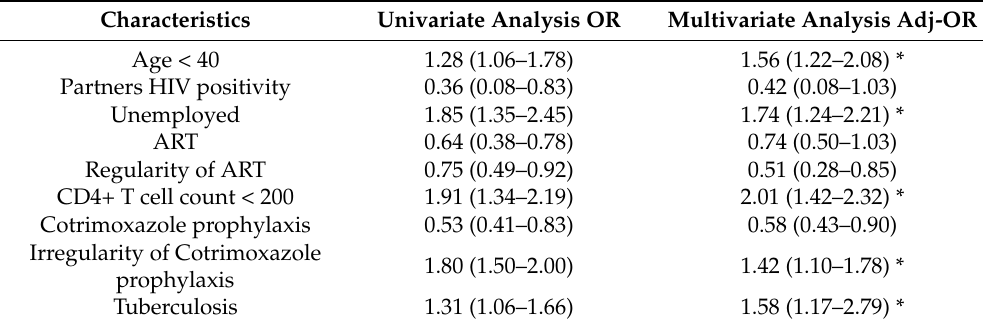
Table 3. Predictors of positivity at Malaria Test in HIV positive